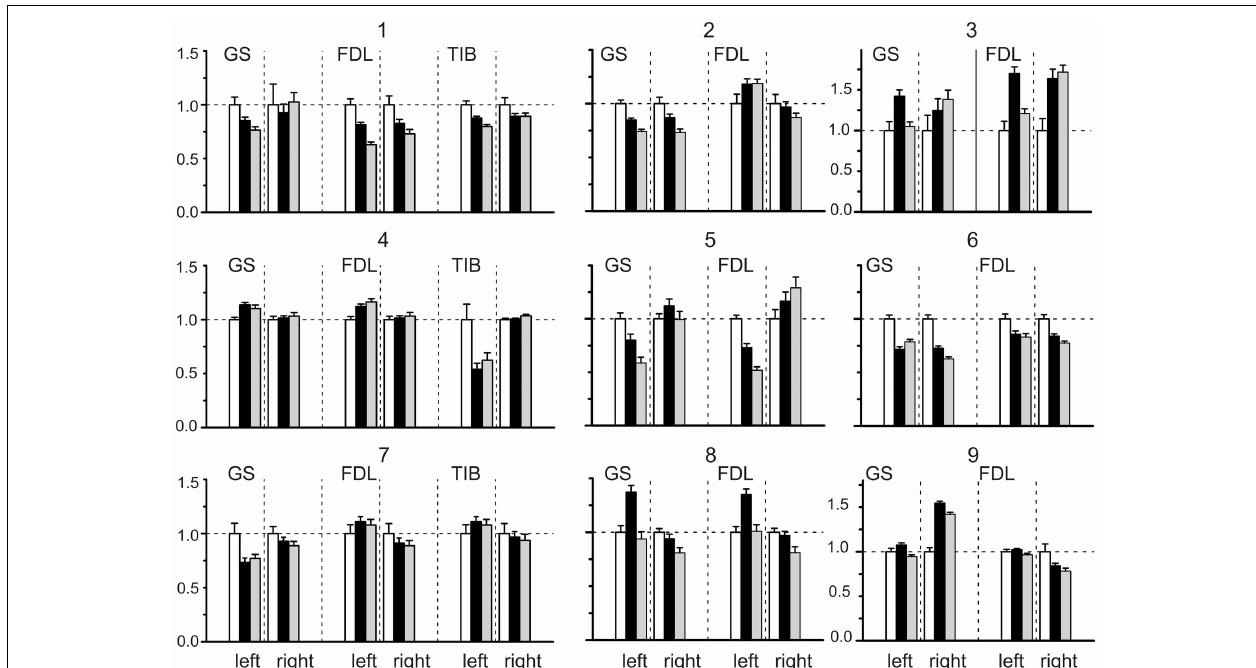
FIGURE 2 | Statistical parameters of the field potentials (FPs) recorded on both sides (left and right) of the spinal cord before (white bars) and after dynorphin B (black bars) and naloxone (gray bars) injections. The normalized parameters of the three sets of FPs recorded bilaterally were compared within each experiment. Each set was connected with ten repetitions of the standard sequences of stimuli applied to the nerves of the